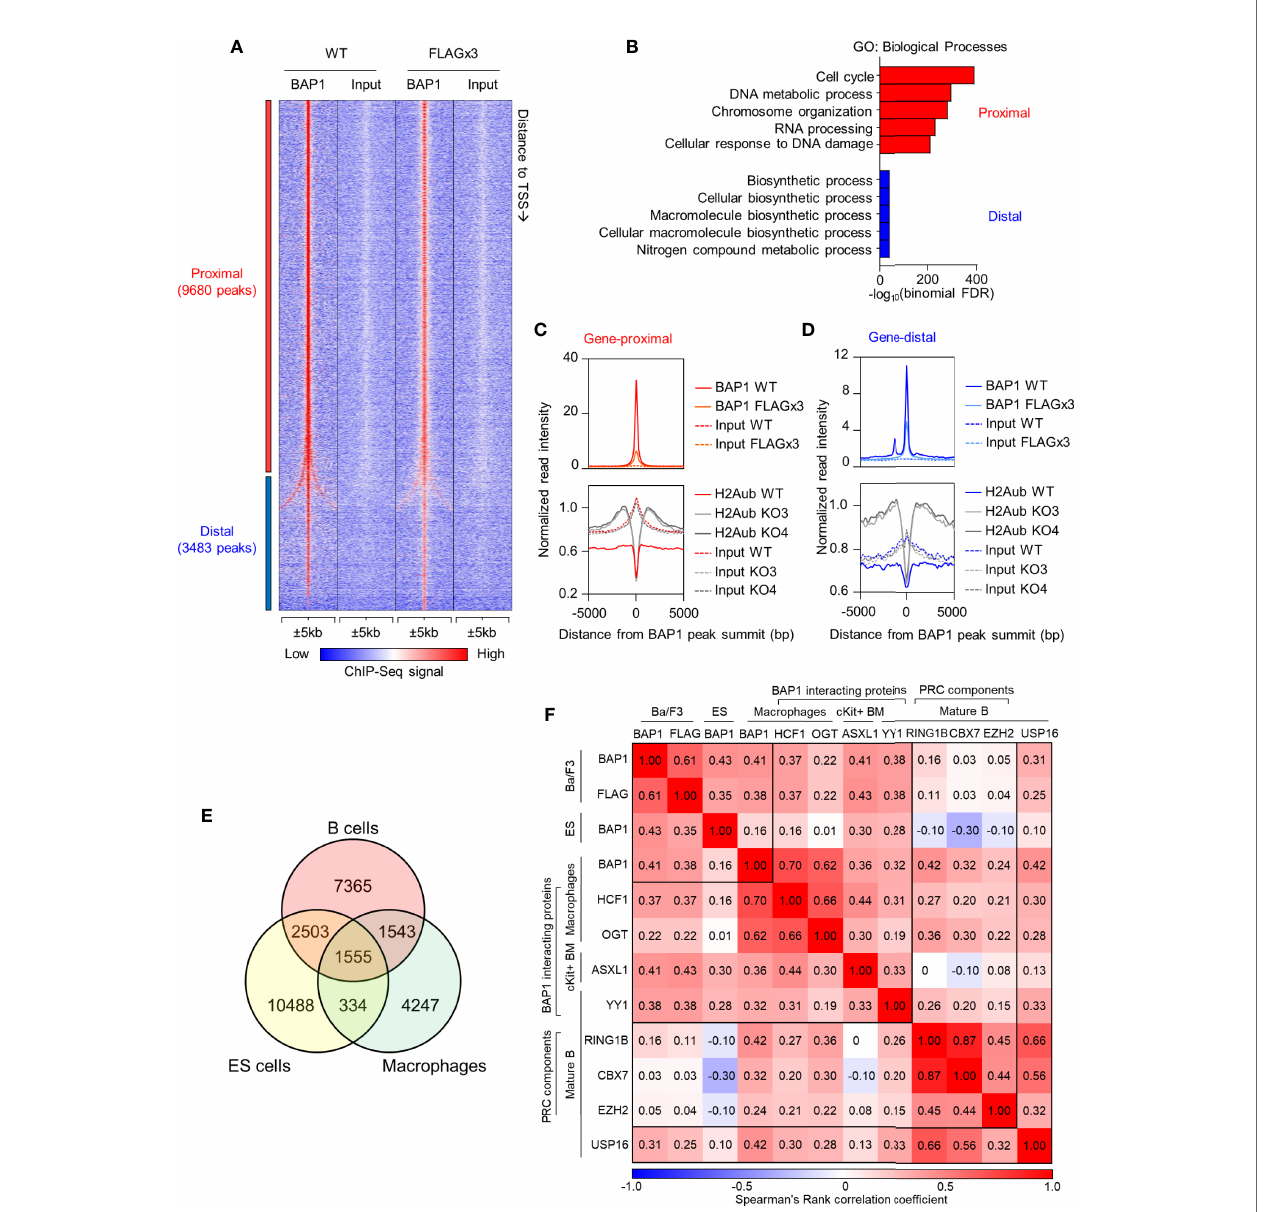
FIGURE 6 | ChIP-Seq analysis of BAP1 binding sites, and the impact of BAP1 loss on histone H2AK119ub levels, in the B cell precursor cell line Ba/F3. (A) Heat map showing the tag density of 13,163 BAP1 binding sites identi fi ed in ChIP-Seq experiments from wild type Ba/F3 B cell lineage precursor cells (WT) and Ba/F3 cells stably expressing triple-FLAG-tagged BAP1 (FLAG x3). The sites are ranked based on their distance to the nearest gene transcriptional start site (TSS). Gene- proximal sites are de fi ned as having the nearest gene TSS within 1kb, and gene-distal sites are de fi ned as having the nearest gene TSS further than 1kb. (B) Gene Ontology analysis of the nearest genes to each BAP1 binding site, performed on the GREAT website (69). The -log 10 (binomial FDR) value for each term is plotted. (C, D) Histograms showing the average normalized tag densities of BAP1 and histone H2AK119ub around the gene-proximal (C) and gene-distal (D) BAP1 binding sites. The tag densities of BAP1 are determined from the ChIP-Seq data of WT and FLAG x3 Ba/F3 cells, and the tag densities of histone H2AK119ub are from the ChIP-Seq data of WT and two Bap1 D / D (KO) Ba/F3 cells lines. (E) Venn diagram comparing the BAP1 binding sites identi fi ed in our ChIP-Seq datasets from B cells with BAP1 binding sites identi fi ed in previous studies in ES-cells and macrophages (38, 75). (F) Analyses of the co-localization of BAP1 binding sites identi fi ed in our ChIP-Seq data with the binding sites for other functionally related transcriptional regulators in previously published studies. Heatmap displaying the Spearman rank correlations between all pairwise comparisons for the BAP1 ChIP-Seq data and the ChIP-Seq datasets of other functionally related transcriptional regulators. Spearman correlations were calculated using the normalized tag densities ( ± 100bp around peak summit) across the entire set of binding sites identi fi ed from the ChIP-Seq experiments. The BAP1 ChIP-Seq from Ba/F3 cells represents our datasets and is described in (A, B) . The others are public datasets, downloaded and re-analyzed using our pipeline. These include the BAP1 ChIP-Seq from ES cells (75), the BAP1, HCF1, and OGT ChIP-Seq from bone marrow derived macrophages (38), the ASXL1 ChIP-Seq from c-Kit+ bone marrow cells (76), the RING1B, CBX7, EZH2, and USP16 ChIP-Seq from quiescent CD43 - resting splenic B cells (17), and the YY1 ChIP-Seq from follicular B cells (CD19 + AA4 - CD21 lo CD23 hi ) (77); all datasets are from